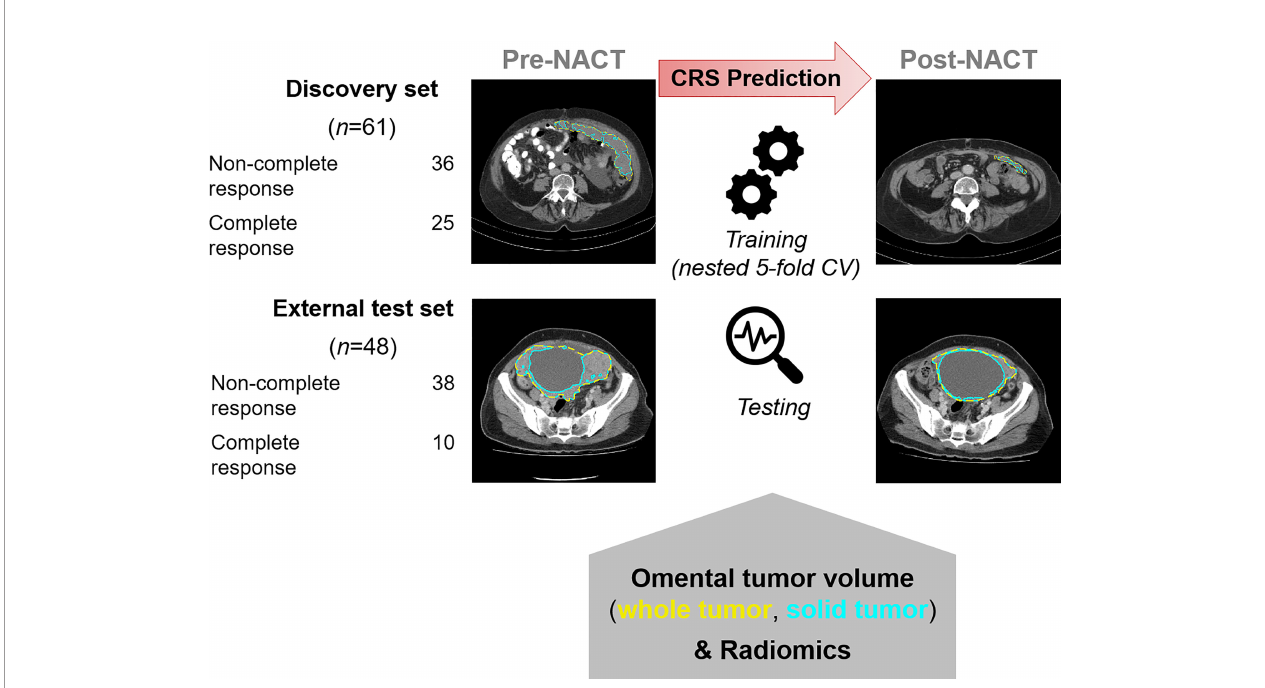
FIGURE 1 | Overall design of the study for identifying radiomic predictors of CRS-con fi rmed response. Pre- and post-NACT CT images were analyzed. CRS classi fi cation is